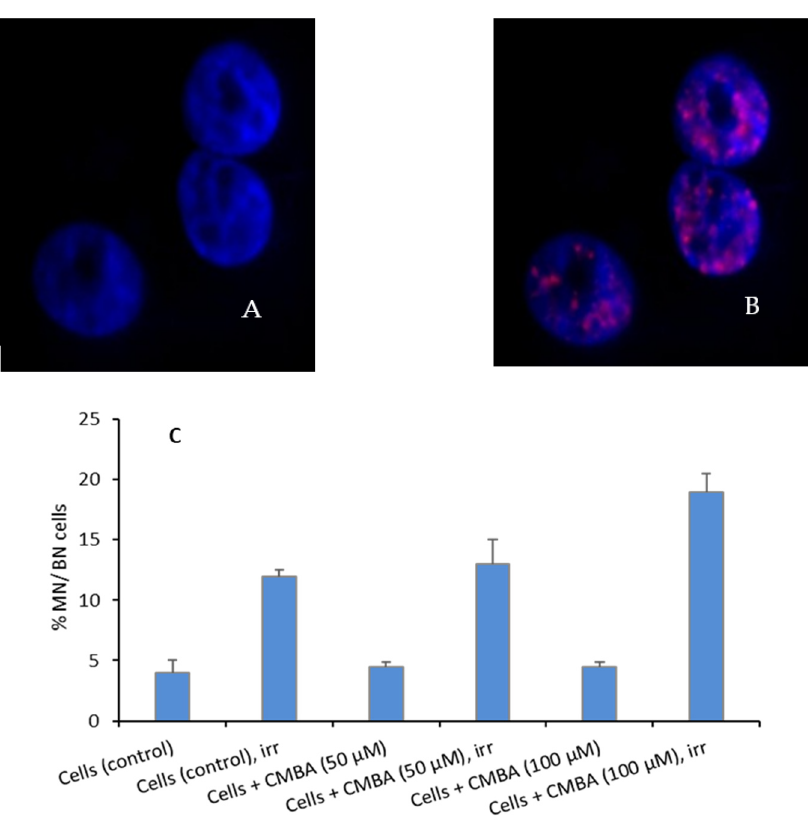
Figure 9. DSB quantification using the γ -H2AX assay (up); ( A ) represents the nuclei stained by DAPI, ( B ) the foci, pink dots, identified by TXR. The number of MN per BN cell is also presented for CMBA (down) ( C ). The error bars represent the standard deviation of the three independent experiments. The images were obtained using 64 × magnification.